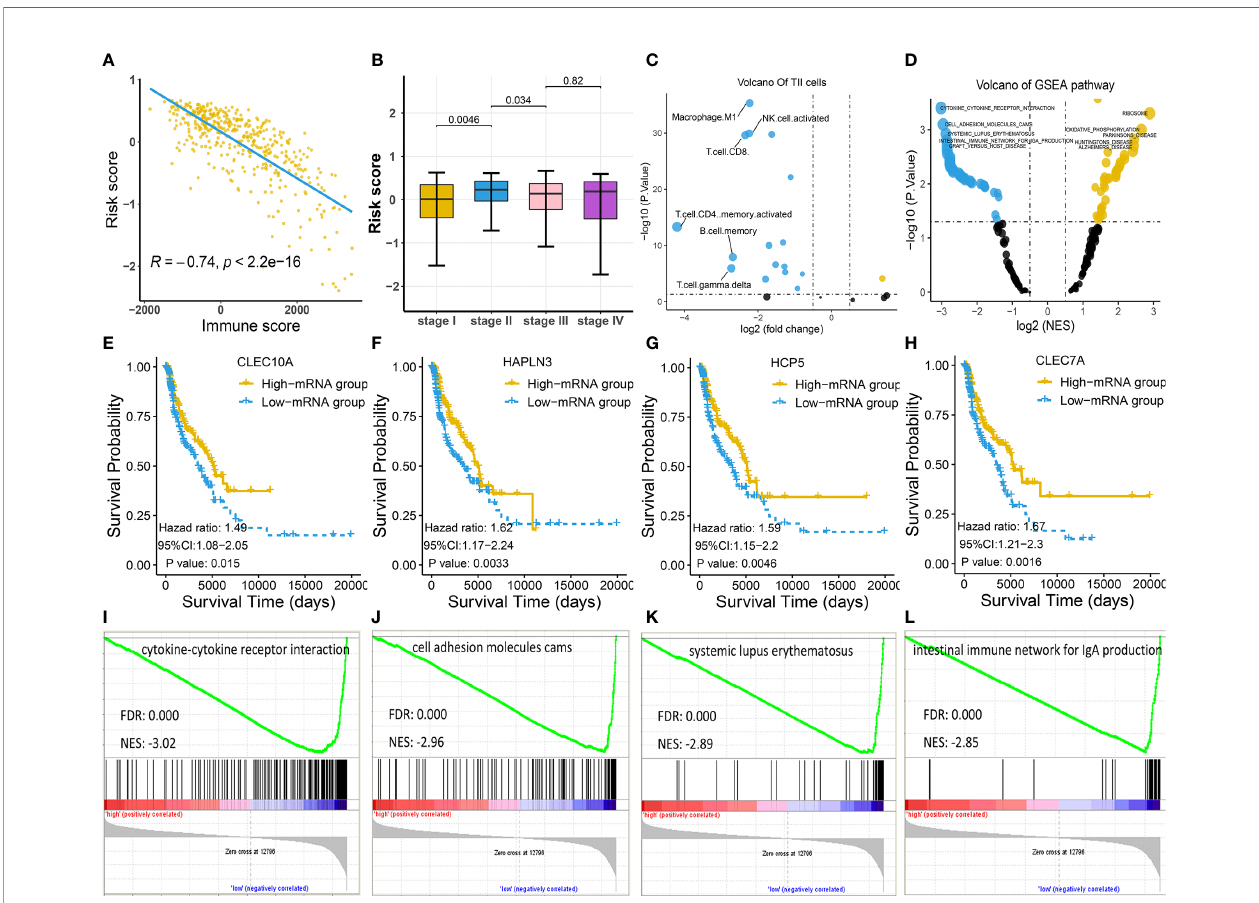
FIGURE 4 | Exploration of the four-gene biomarker (A – C) Risk scores of melanoma patients from TCGA cohort were calculated according to the four-gene biomarker, and the association of risk scores with common clinical characteristics were investigated. (A) Risk score was negatively correlated with immune score, consistent with low-risk patients who had a prolonged survival in melanoma. (B) There was a marked difference in risk score between stage I and stage II, as well as between stage II and stage III, implying qualitative change occurred after stage II. (C) The numbers of M1 macrophage, NK, CD4 + , and CD8 + T cells were critically elevated in the low-risk group (the blue dot indicates TIICs whose counts are increased in the low-risk group, while the yellow dot indicates TIICs whose counts are increased in the high-risk group). (D) KEGG pathway analysis by GSEA displayed signi fi cantly differentially enriched pathways between the low-risk and high-risk groups. Each blue dot represents a signi fi cantly enriched pathway in the low-risk group, while yellow dot represents that in the high-risk group. (E – H) Four genes, CLEC7A , CLEC10A , HAPLN3 , and HCP5 , had a signi fi cant relevance with respect to survival; this is indicative of their anti-tumoral roles in melanoma. (I – L) The top four pathways in the low-risk group were all immune-related, indicating more active immune function in low-risk group compared to in the high-risk